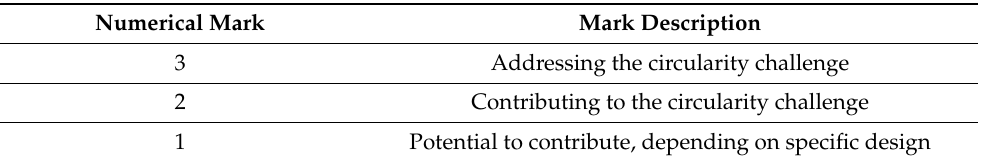
Table 1. Marking system used for the evaluation of NBS units and supporting units with respect to UCC1 and 2.